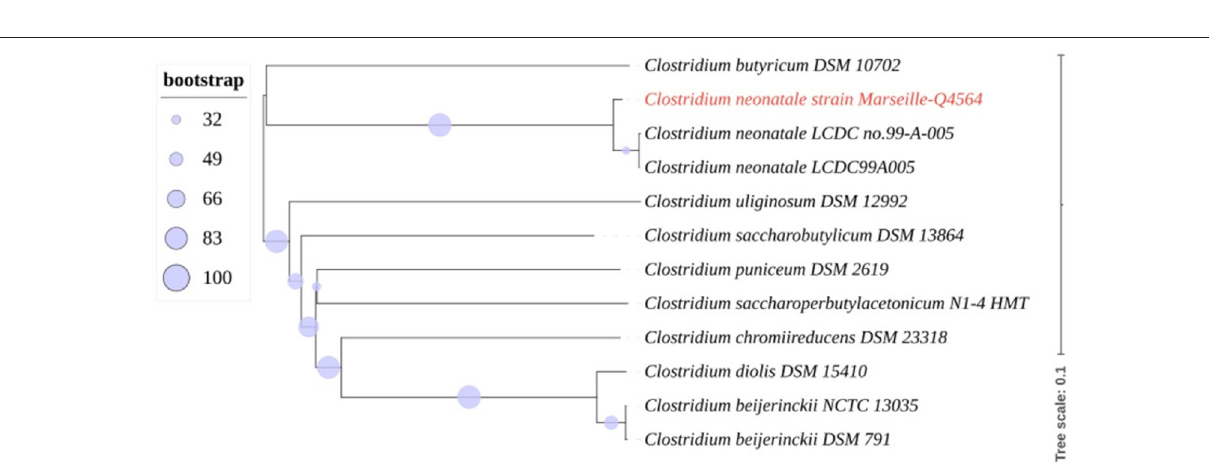
for environmental cleaning in case of sporulating C.